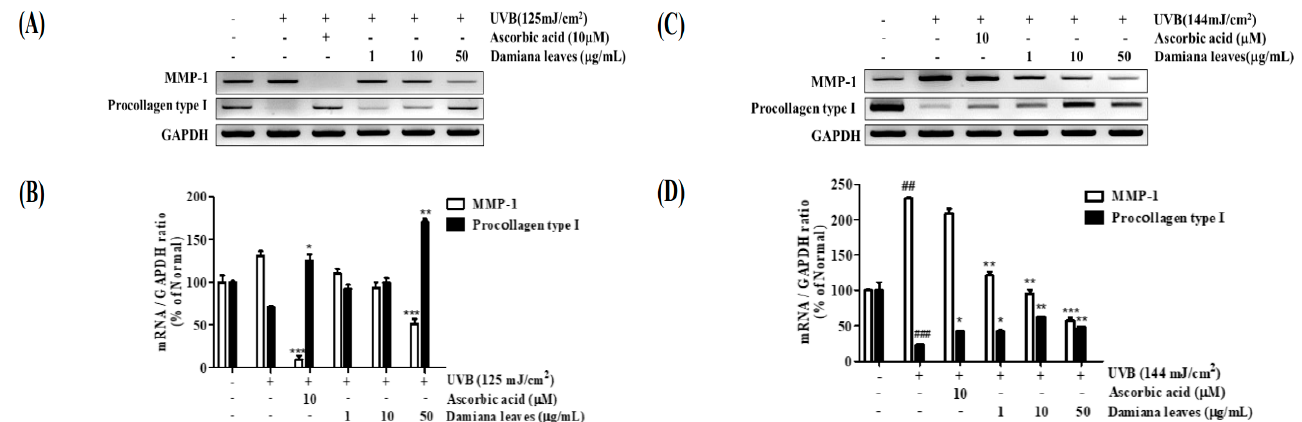
Figure 6. Effect of Damiana leaves extract on mRNA levels MMP-1 and procollagen type I in UVB- irradiated HaCaT ( A , B ) and HDF ( C , D ) cells. Data are presented as the mean ± SD. # and * indicate significant differences from the non-irradiated control and UVB-treated groups, respectively. ## and ### p < 0.01 and 0.001 vs. the non-treated group, respectively. *, ** and *** p < 0.05, 0.01, and 0.001 vs. the UVB-treated control, respectively.